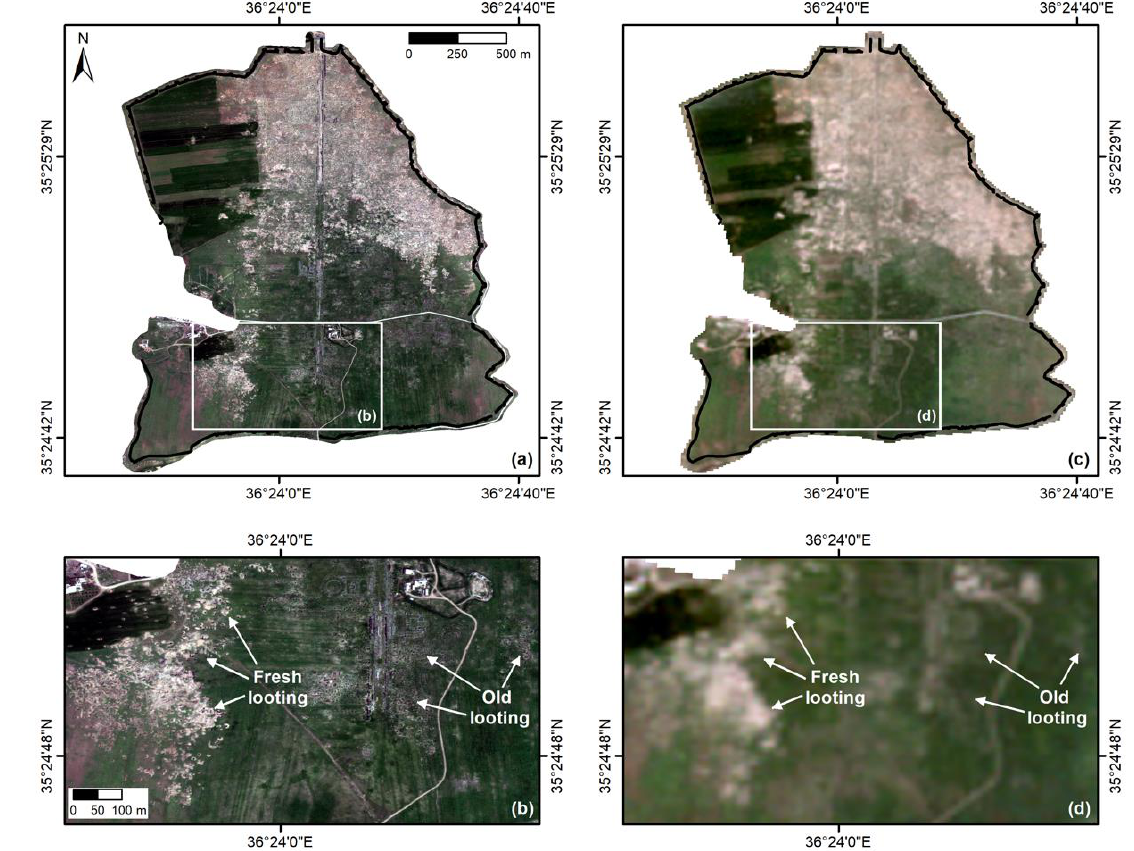
Figure 9. Archaeological looting at Apamea (Syria) captured with: ( a ) pansharpened 30-cm WorldView-2 image (03/04/2017) and ( c ) 10-m Sentinel-2 image (21/04/2017), displayed as true-color images (R: Band 3—red; G: Band 2—green; B: Band 1—blue, and R: Band 4—red; G: Band 3—green; B: Band 2—blue, respectively). Zoomed views ( b , d ) highlight areas of fresh vs. old looting features. WorldView-2 product © 2018 DigitalGlobe, Inc. Distributed by e-GEOS S.p.A. Contains Copernicus Sentinel-2 data 2017.